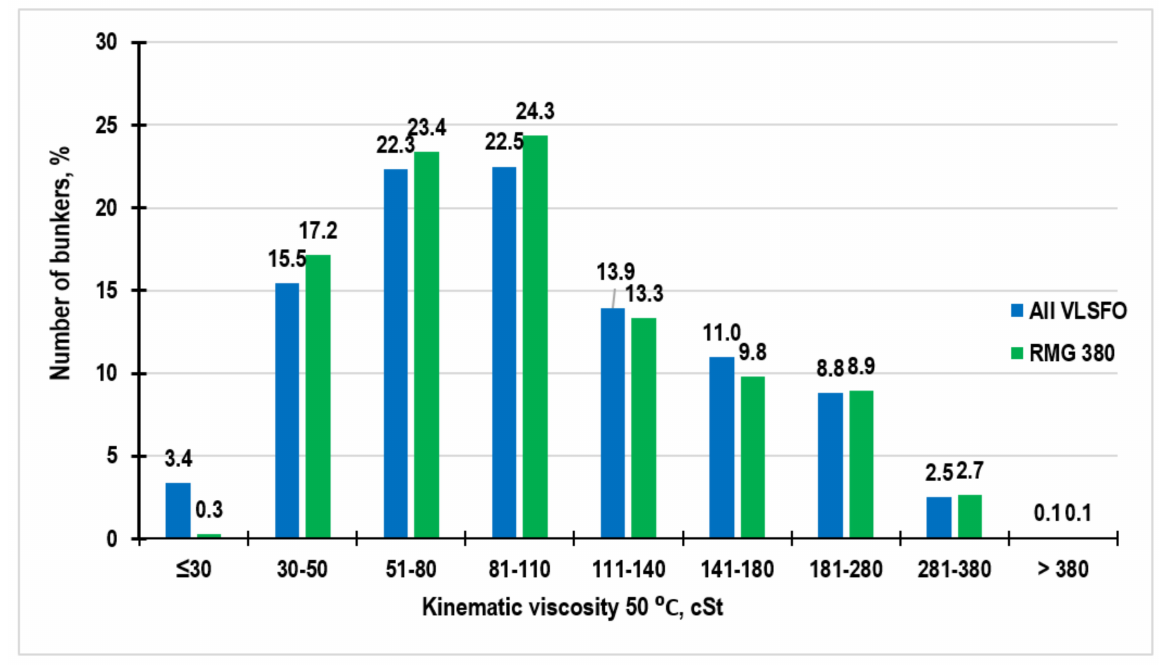
Figure 2. All VLSFO and RMG 380 kinematic viscosity (at 50 ◦ C)